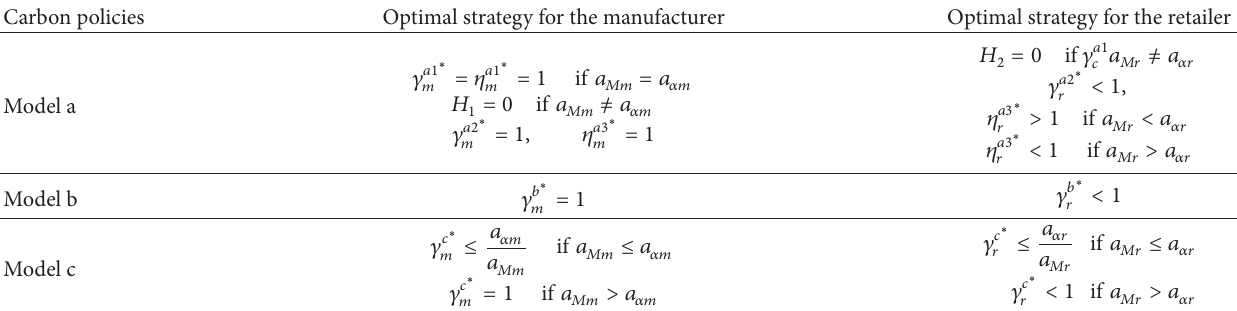
Table 2: The optimal misreporting strategies for the three models under symmetric